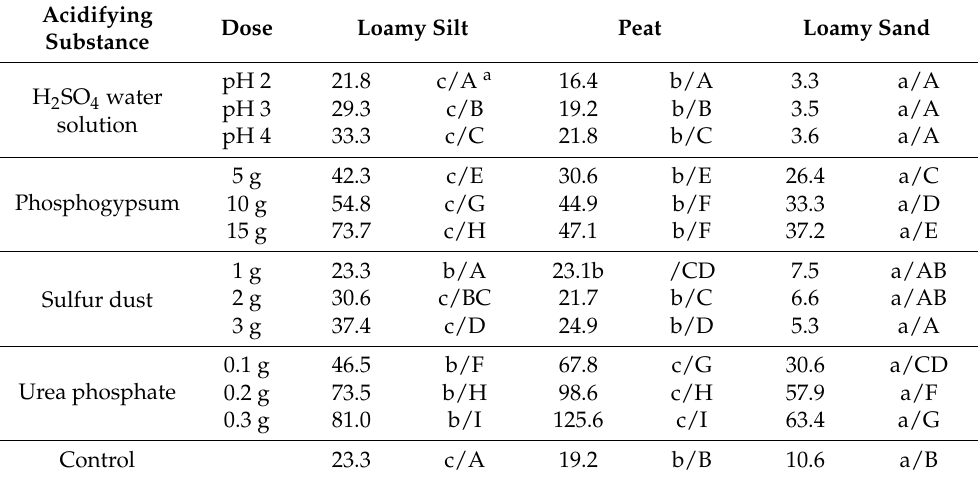
Table 4. Effects of acidifying substances after 12 months on the content of available phosphorus in loamy silt, peat and loamy sand